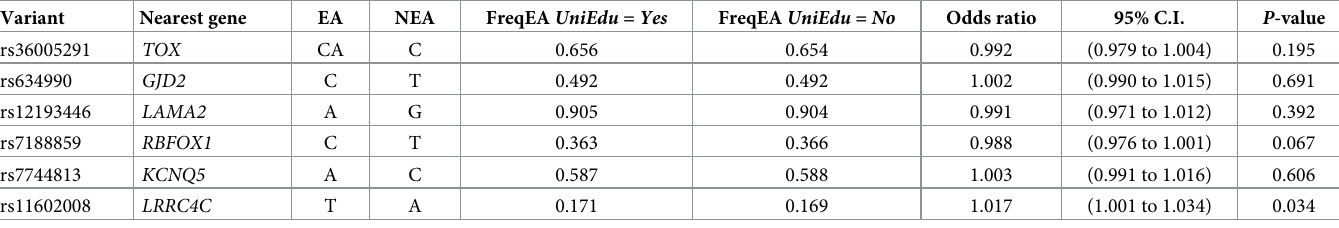
Table 5. Gene-environmental correlation (rGE) between genetic variants and University education in the Stage-II sample. SNPs were tested using logistic regression. The effect allele is the allele associated with a more myopic refractive error in a linear regression test for the marginal effect of the variant. The frequency of the effect allele is reported in participants who did or did not attend University ( UniEdu = Yes / No